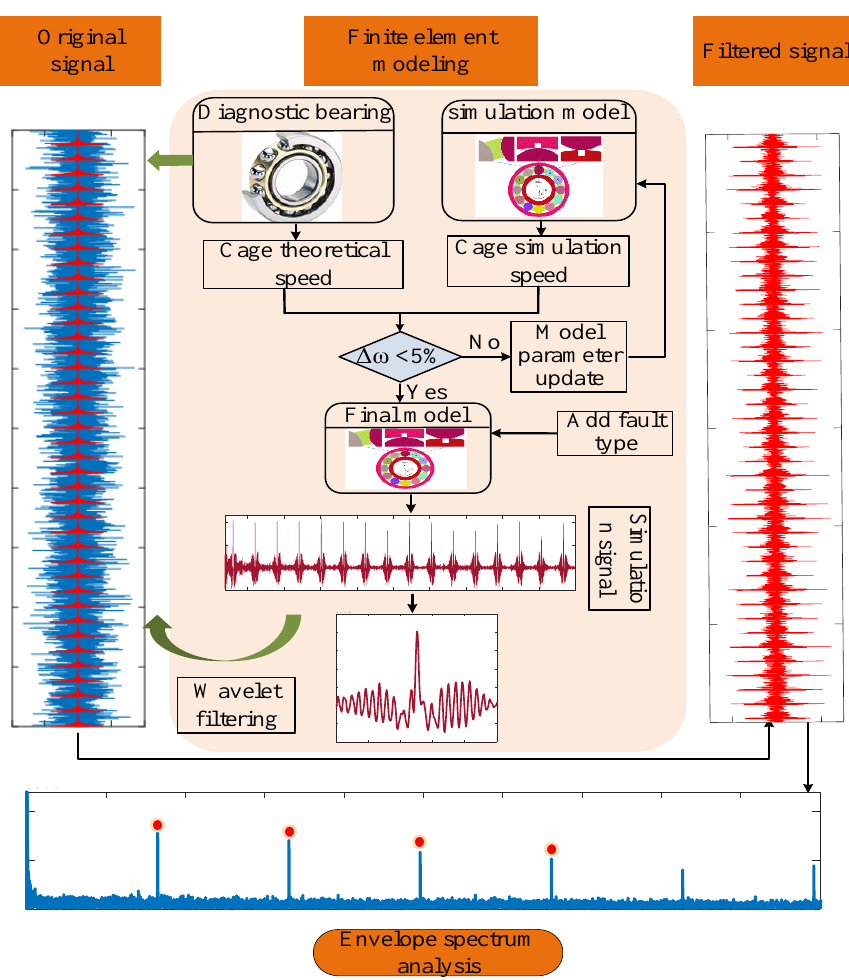
Figure 2. The procedure of personalized diagnosis using FEM-based wavelet